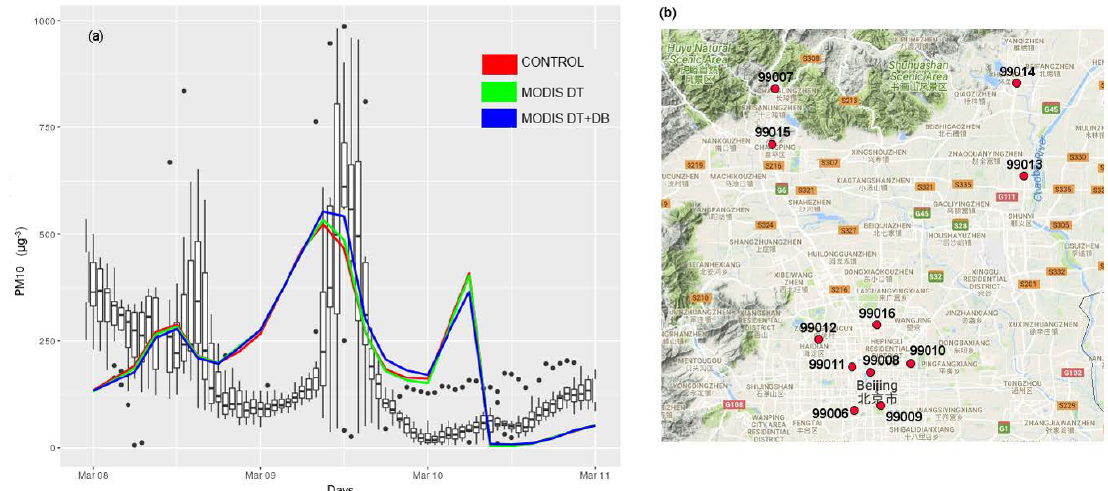
Figure 10. (a) March 2013 PM 10 time series for the measurements recorded at the 11 stations available in the Beijing (39.9 ◦ N, 116.4 ◦ E) mu- nicipality and the simulations performed with the ECMWF model in the different configurations (CONTROL in red, DT in green and DTDB in blue). (b) Location and identification code of the observation stations around the Beijing area. The map covers an area of approximately 40km 2